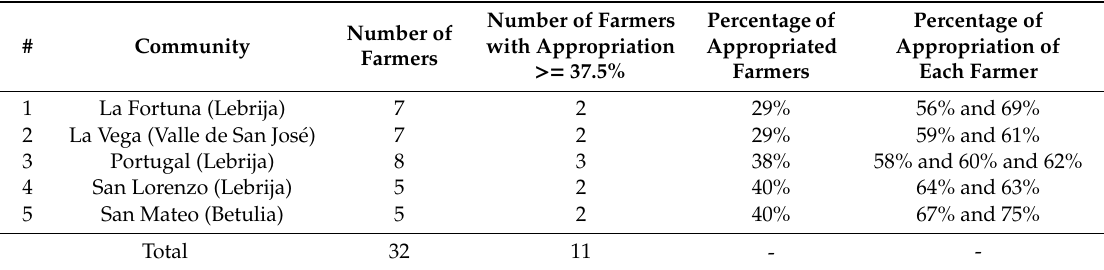
Table 5. Participating communities and results.